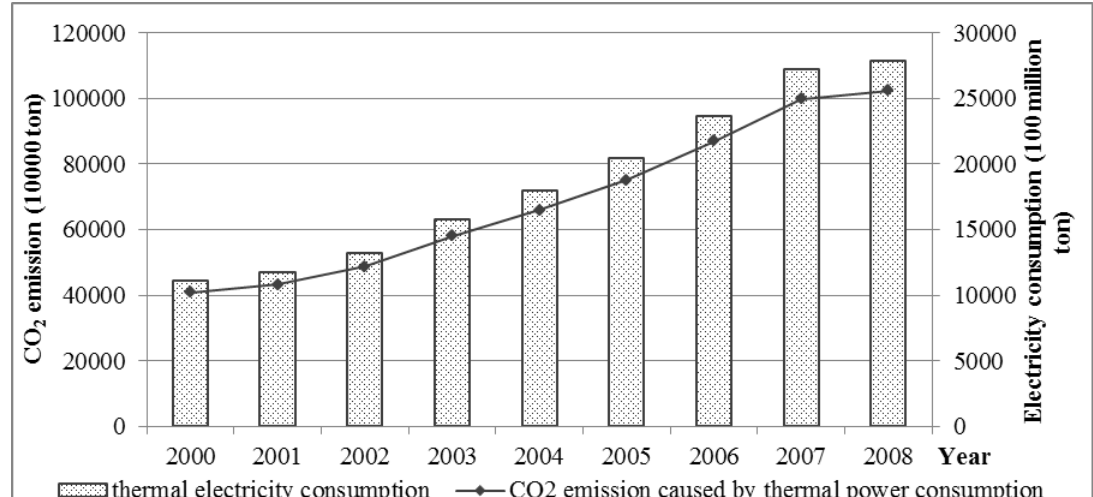
emissions in China from 2000 to 2